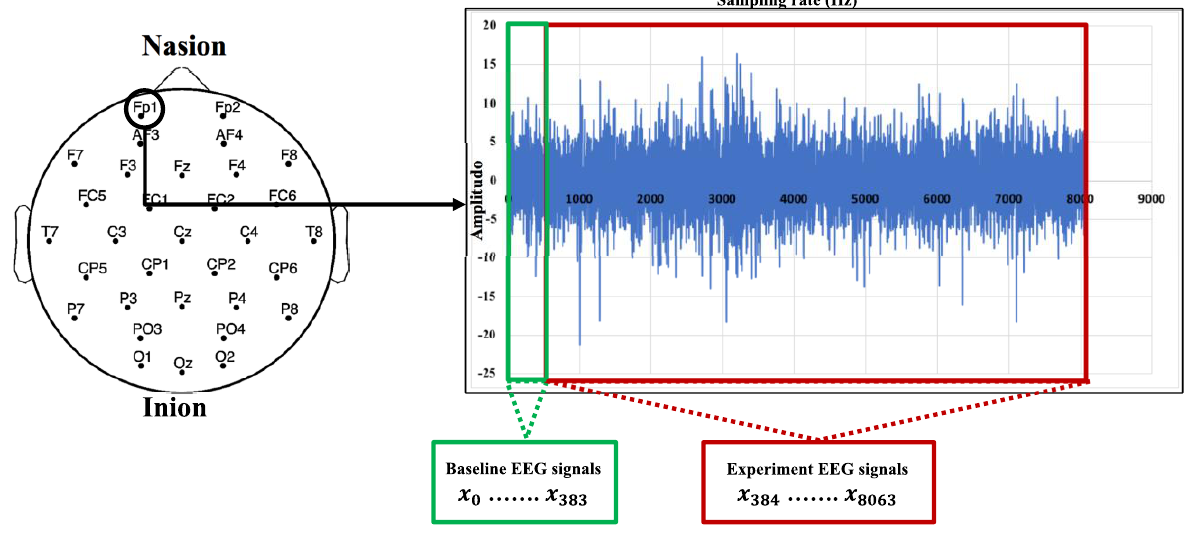
Figure 6. EEG signal segmentation processes on channel